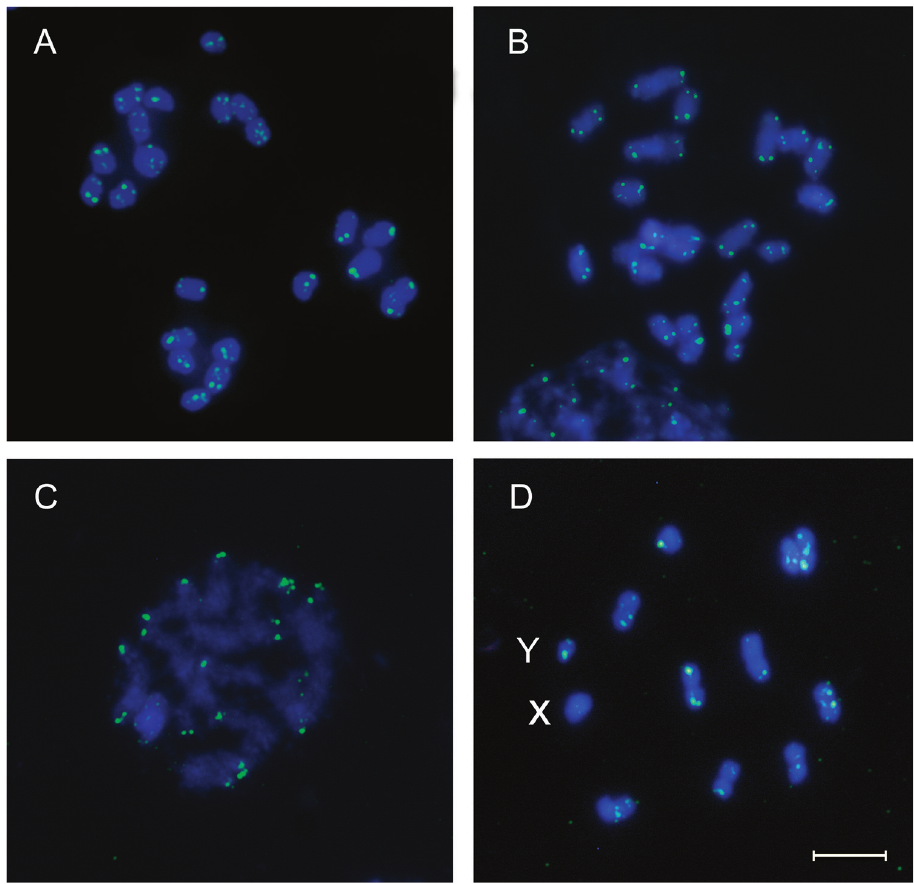
Figure 1. Fluorescence in situ hybridization with (TTAGG) telomeric probe (green signals) on mitotic n and meiotic chromosomes (counterstained with DAPI in blue) of four Triatominae species. A Triatoma infestans (2n=22), spermatogonial prometaphase B Triatoma dimidiata (2n=23), spermatogonial prometa- phase C Dipetalogaster maxima (2n=22), pachytene stage D Rhodnius prolixus (2n=22), first meiotic divi- sion showing 10 bivalents and two sex chromosomes (X and Y). Scale bar: 5